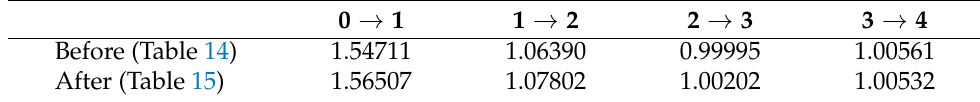
Table 16. Development factors before and after the adjustment.